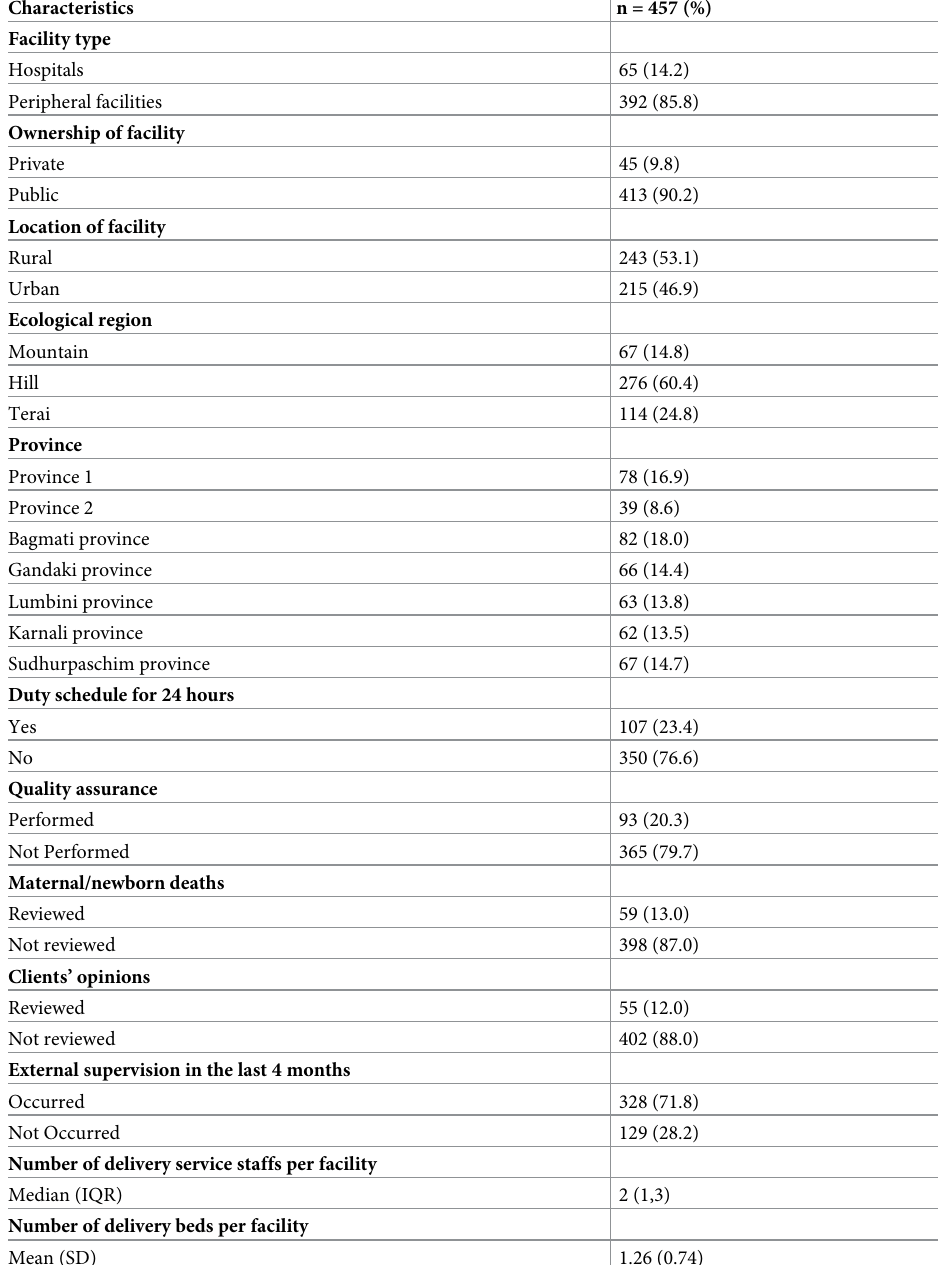
Table 1. General characteristics of health facilities (n =